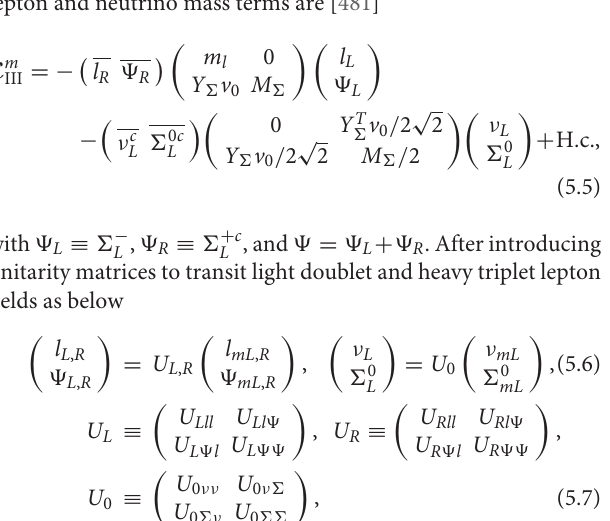
100 fb − 1 [368, 448]. =